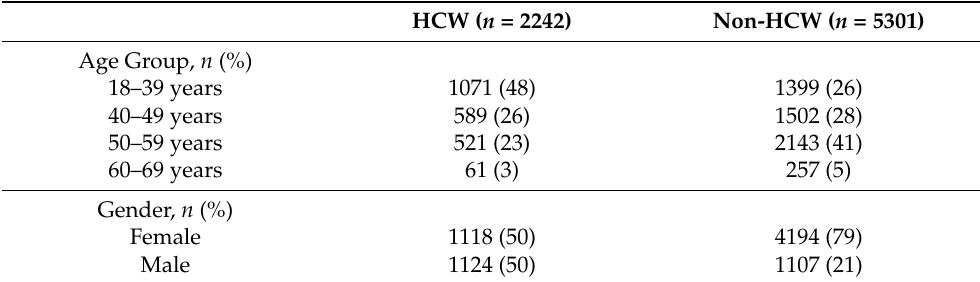
Table 1. Characteristics of healthcare workers (HCW) and non-healthcare workers who underwent screening for SARS-CoV-2 antibodies and completed the study.